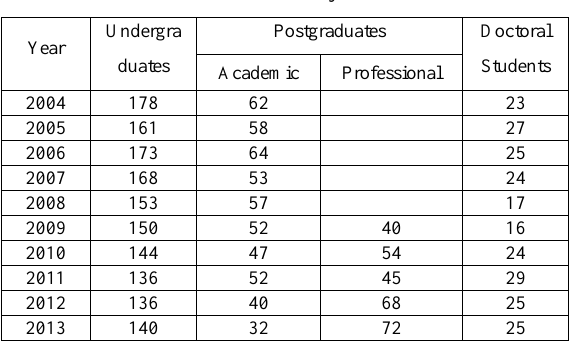
Table 5. 2004-2013 the Number of GIS Graduates in